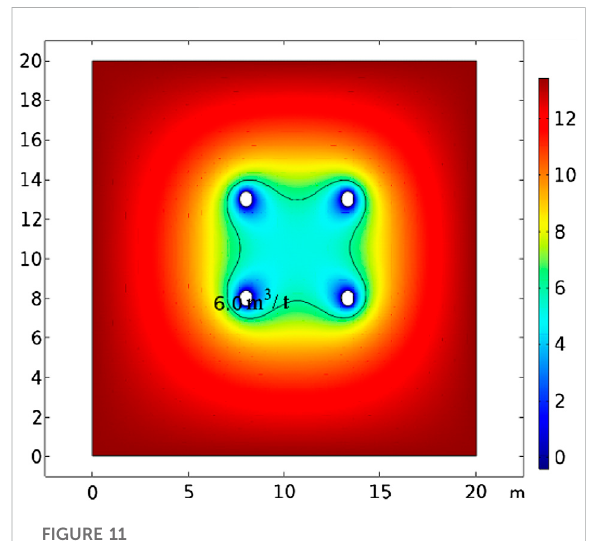
FIGURE 11 Gas content distribution of the minimum horizontal section of the equivalent ellipsoid hole.